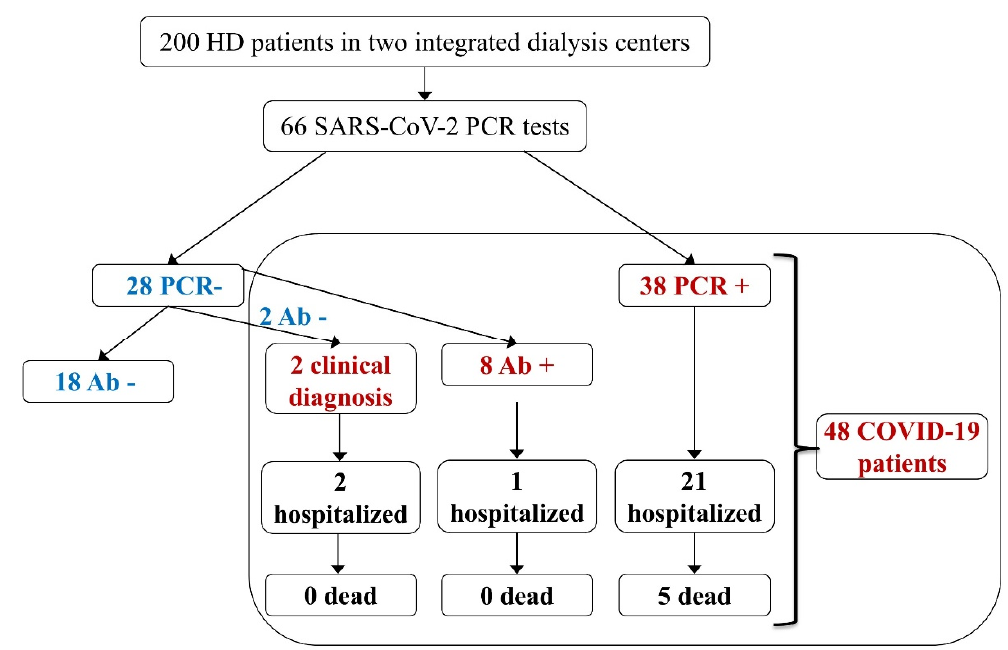
Figure 1. Hemodialisis patients diagnostic flow chart. HD: hemodialysis; PCR + : PCR positive patients; PCR − : PCR negative patients; Ab + : SARS-CoV-2 seropositive patients; Ab − : No antibodies.